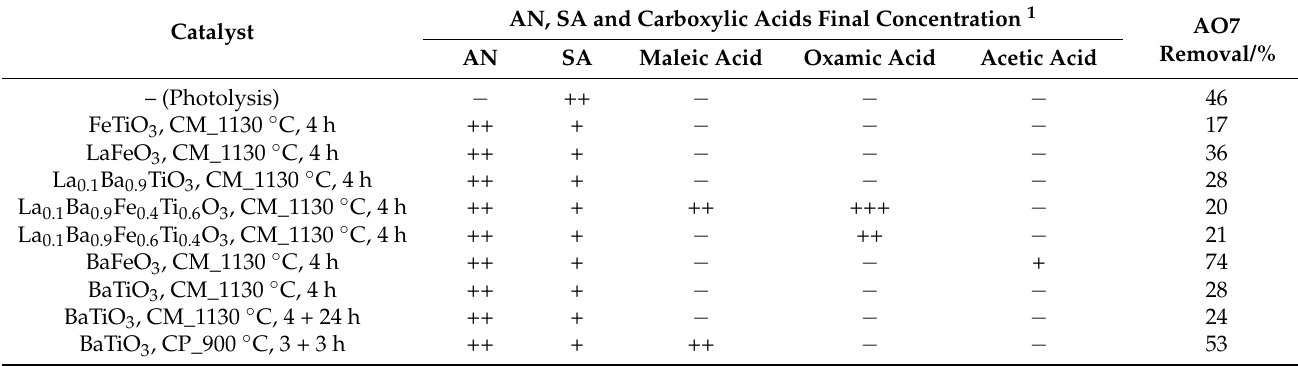
Table 2. Results of the photocatalytic assays with sunlight using different perovskites: [catalyst] = 0.5 g L − 1 ; [AO7] 0 = 5 mg L − 1 ; Volume = 50 mL; Assay duration—4